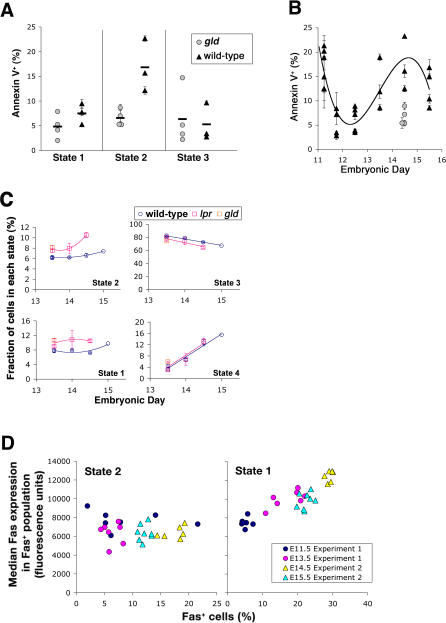
FAS Mediates Apoptosis in State 2(A) Fraction of cells that are ANXA5+ in E14.5 gld embryos (circles) compared with strain- and age-matched wild-type embryos (triangles) in each of states 1, 2, and 3. Each data point represents the mean ± standard error of the mean for a litter of embryos; four litters containing 18 gld embryos were compared with three litters containing a total of 23 wild-type embryos; differences for state 2 were significant at the p < 0.0001 level using a two-tailed Student's t-test (non-equal variance).(B) State 2 ANXA5 binding data shown in (A), plotted together with the ANXA5 binding data for the entire E11–E15.5 period from Figure 4B.(C) Distribution of cells in the four fetal liver states shows an increase in state 2 cells in E14.5 and E13.5 lpr (magenta) and gld (orange) embryos, compared with strain- and age-matched wild-type embryos (blue). Each data point is the mean ± standard error of the mean of 5–12 embryos from the same litter. There is a 1.58-fold increase in x
2 in gld and lpr embryos at E14.5 (p < 0.0001) and a 1.29-fold increase at E13.5 (p < 0.0001).(D) Median FAS expression per cell in the FAS+ cell population in states 1 and 2. Each point represents data from an individual embryo. Two experiments are shown; in each, two litters of different embryonic ages were examined simultaneously. No normalization was performed on the fluorescence data.